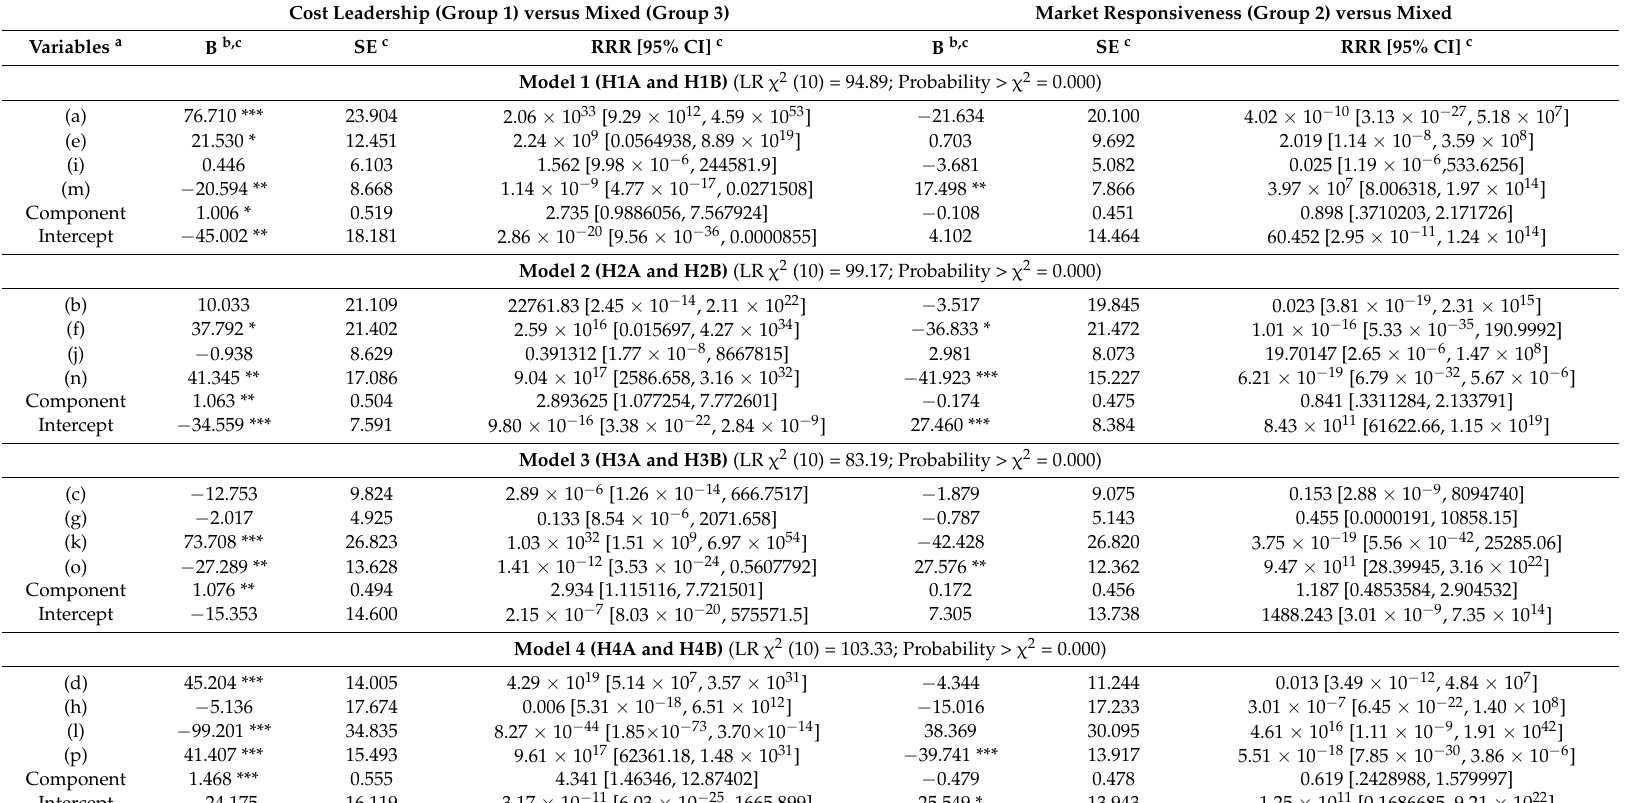
Table 7. Results of multinomial logit